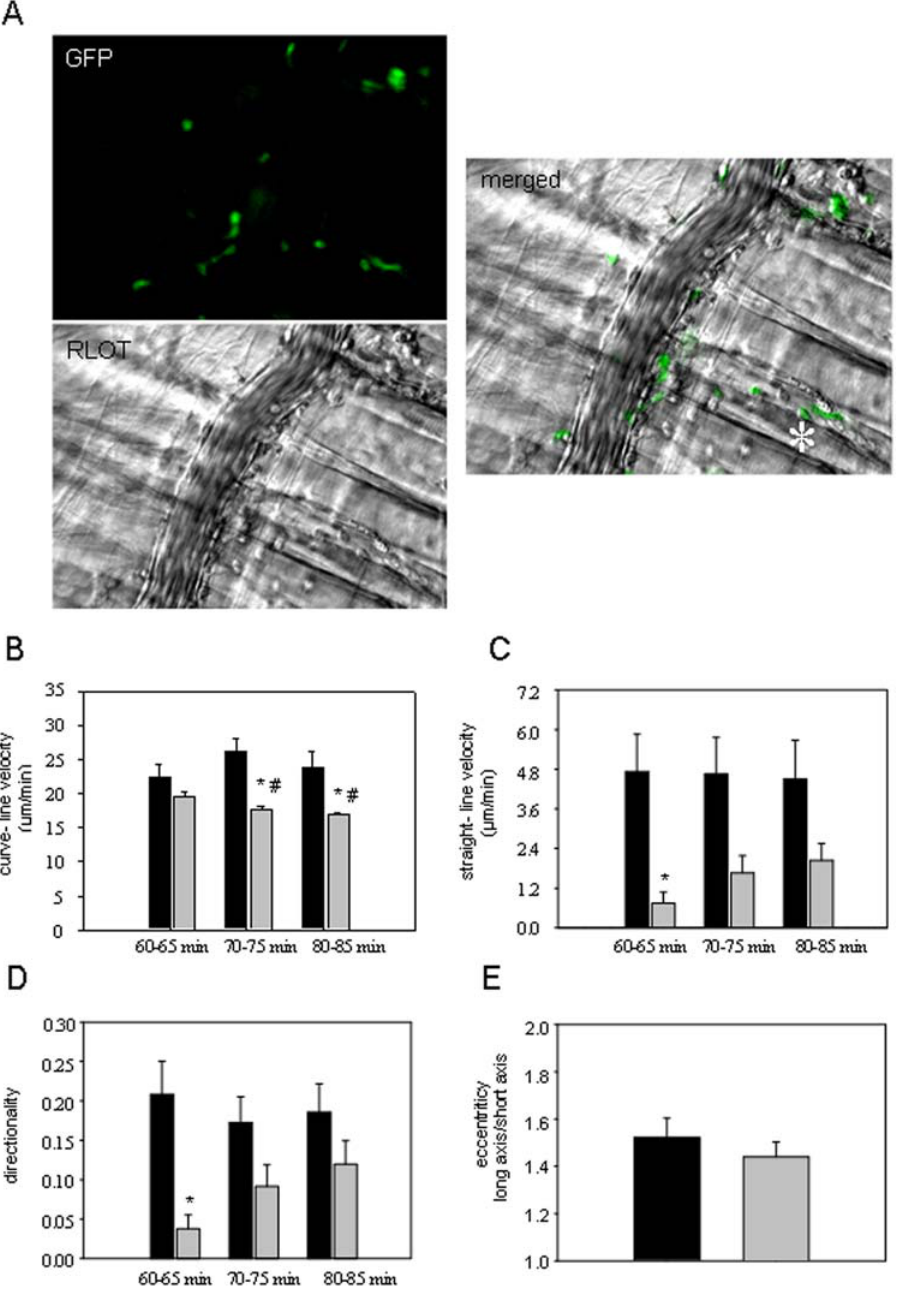
Figure 8. Migration patterns of GFP-positive and GFP-negative cells. A: representative in vivo microscopy images show transmigration of GFP-positive (GFP-image) and GFP-negative cells (RLOT-image) at 60 min after microinjection of MCP-1 in Cx3CR1 gfp/gfp mice (objective magnification 20 6 ; asterisk shows the site of microinjection). B–E: The motility parameters, curve-line migration velocity (B), straight-line migration velocity (C), and directionality (D) of interstitially migrating, GFP-positive (monocytes, gray bars) and GFP-negative cells (neutrophils, black bars) were analyzed at 60, 70, and 80 min after microinjection of MCP-1 for 5 min, respectively; mean 6 SEM; *p , 0.05 vs. GFP-negative cells; # p , 0.05 vs. 60–65 min; n=5. E: polarization of GFP-negative cells (black bars) and GFP-positive cells (gray bars) analyzed at 70 min after microinjection of MCP-1; mean 6 SEM,